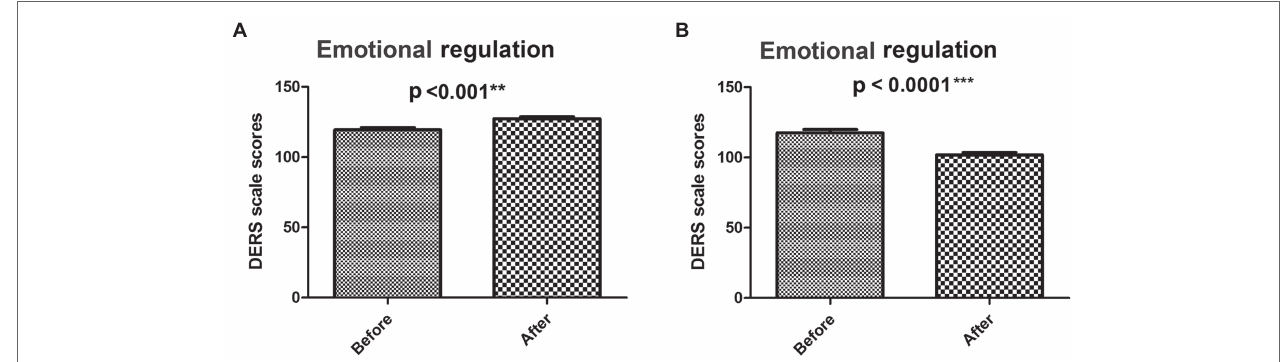
FIGURE 4 | Analysis of total DERS scores before and after intervention. The dynamic DERS scores before and after GMIT intervention in control group (A) and experimental group (B) . ** p < 0.01 and *** p <